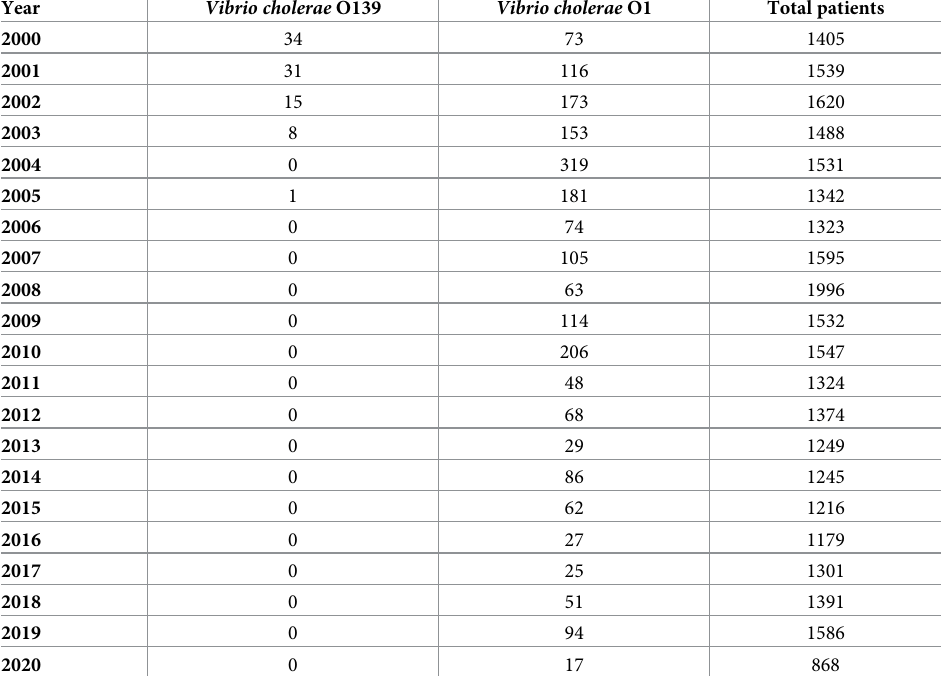
Table 1. Yearly total Vibrio cholerae O139 and Vibrio cholerae O1 among diarrhoeal patients of Matlab Health and Demographic Surveillance System (HDSS) who attended to the Matlab Hospital of icddr,b; Bangladesh (2000–2020).